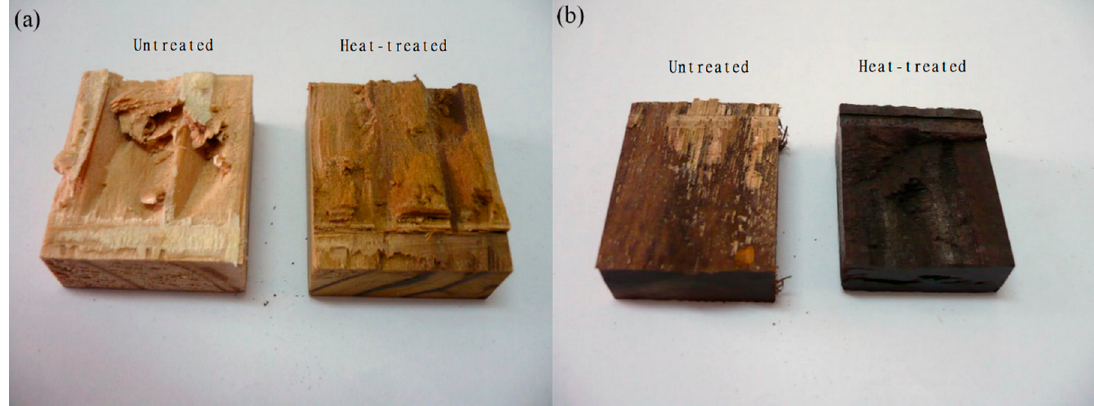
Figure 4. Appearances of untreated and heat-treated Japanese cedar ( Cryptomeria japonica ) ( a ) and Formosa acacia ( Acacia confusa ) ( b ) wood with polyvinyl acetate (PVAc) adhesive after the normal shear strength test.